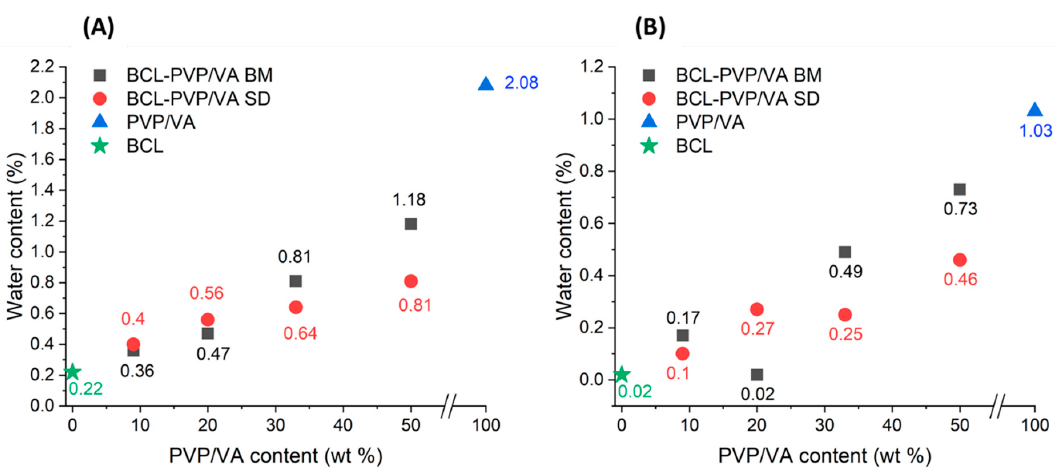
Figure 5. Water content in raw compounds and BCL-PVP / VA solid dispersions obtained by either